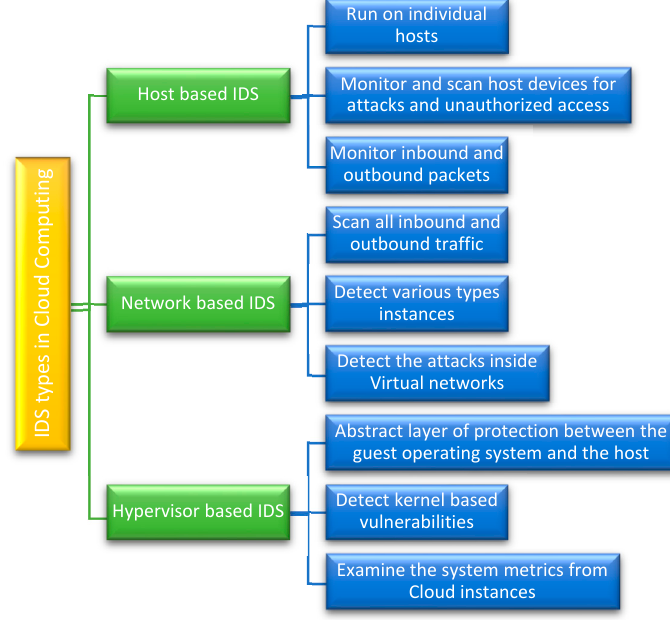
Figure 2. Types of intrusion detection system (IDS) in Cloud Computing.